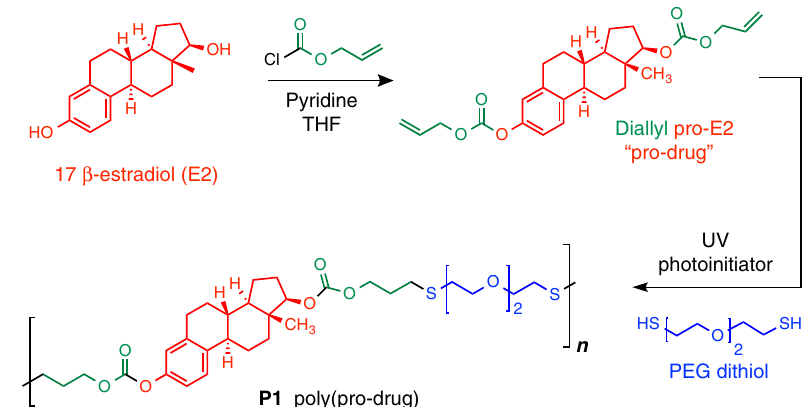
Fig. 2 Synthesis of P1, a polyprodrug of E2 with hydrolytically cleavable carbonate linkages